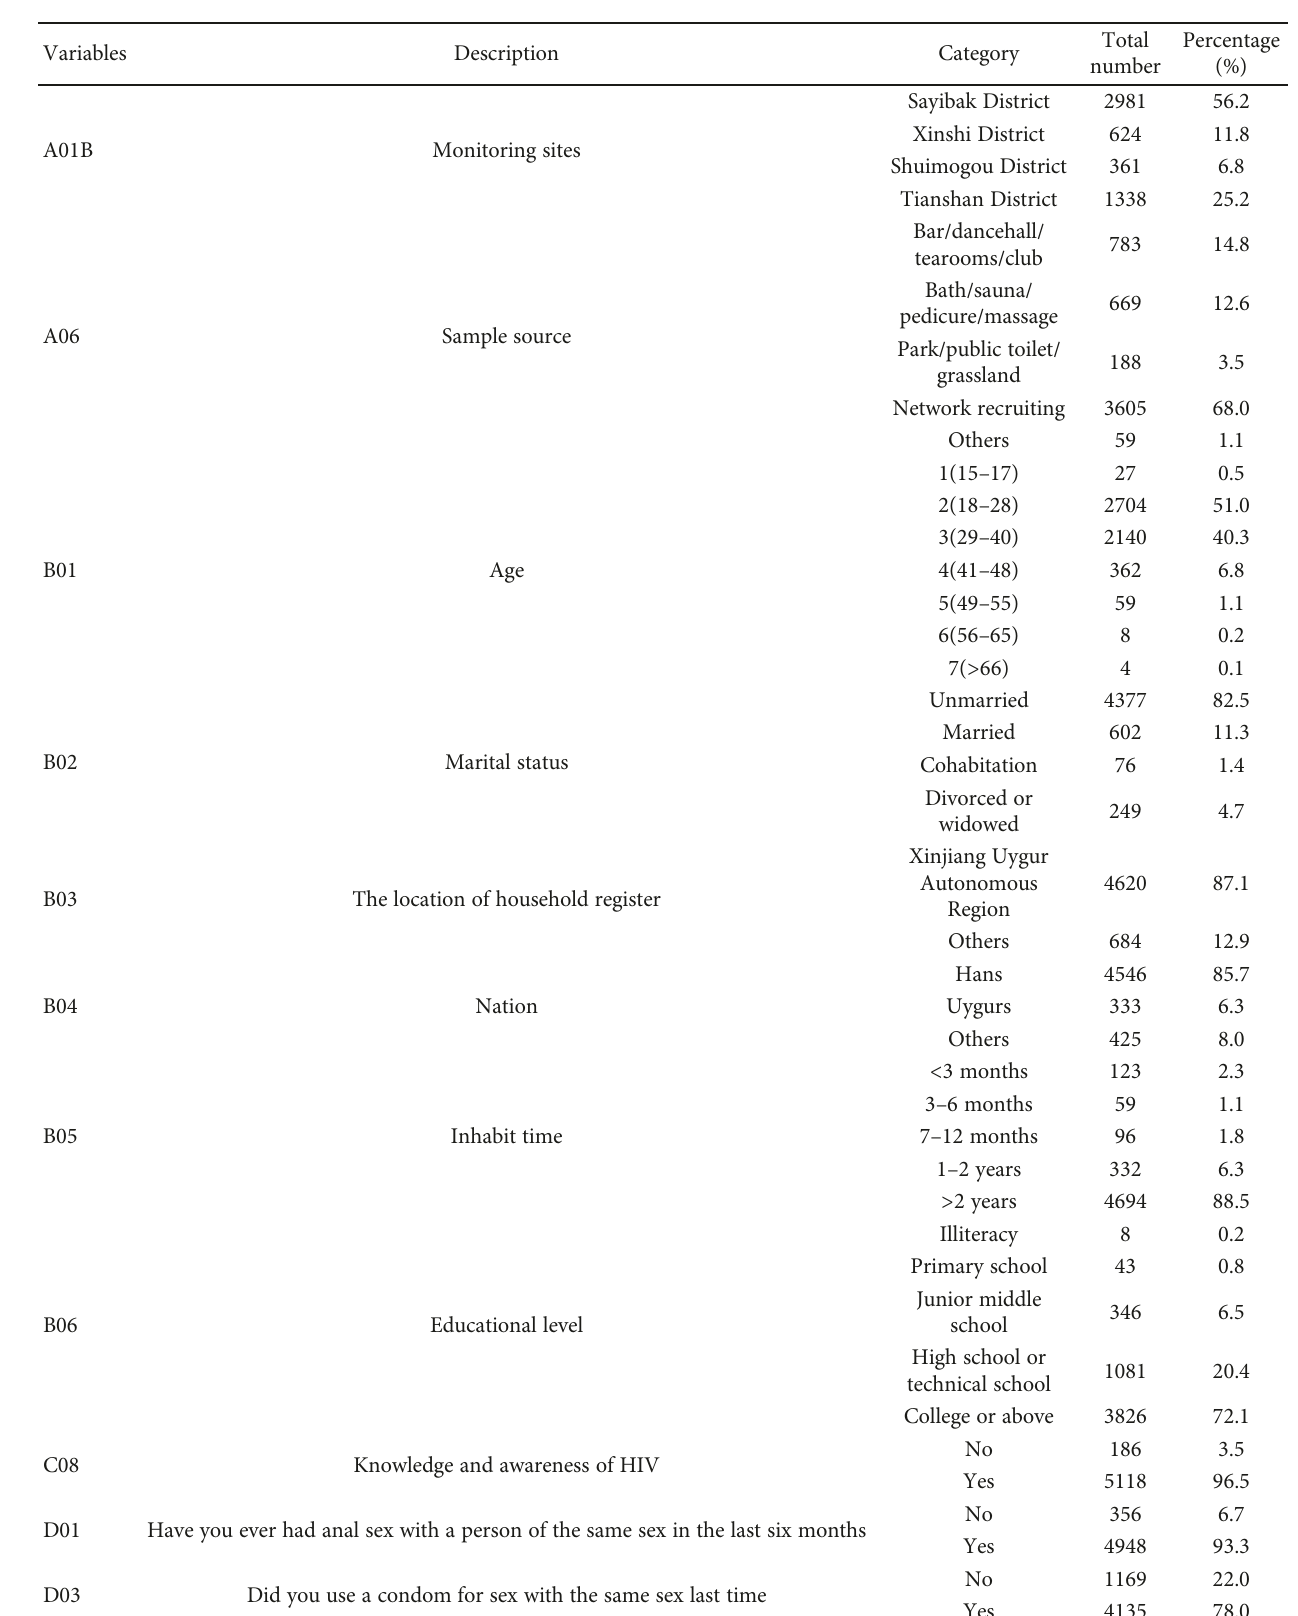
Table 1: Details of the attributes of the MSM